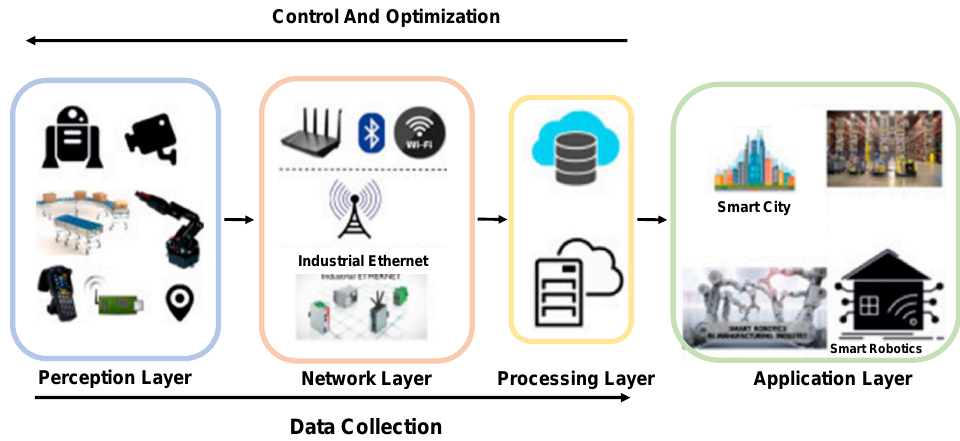
Figure 2. A typical I-IoT SCADA system